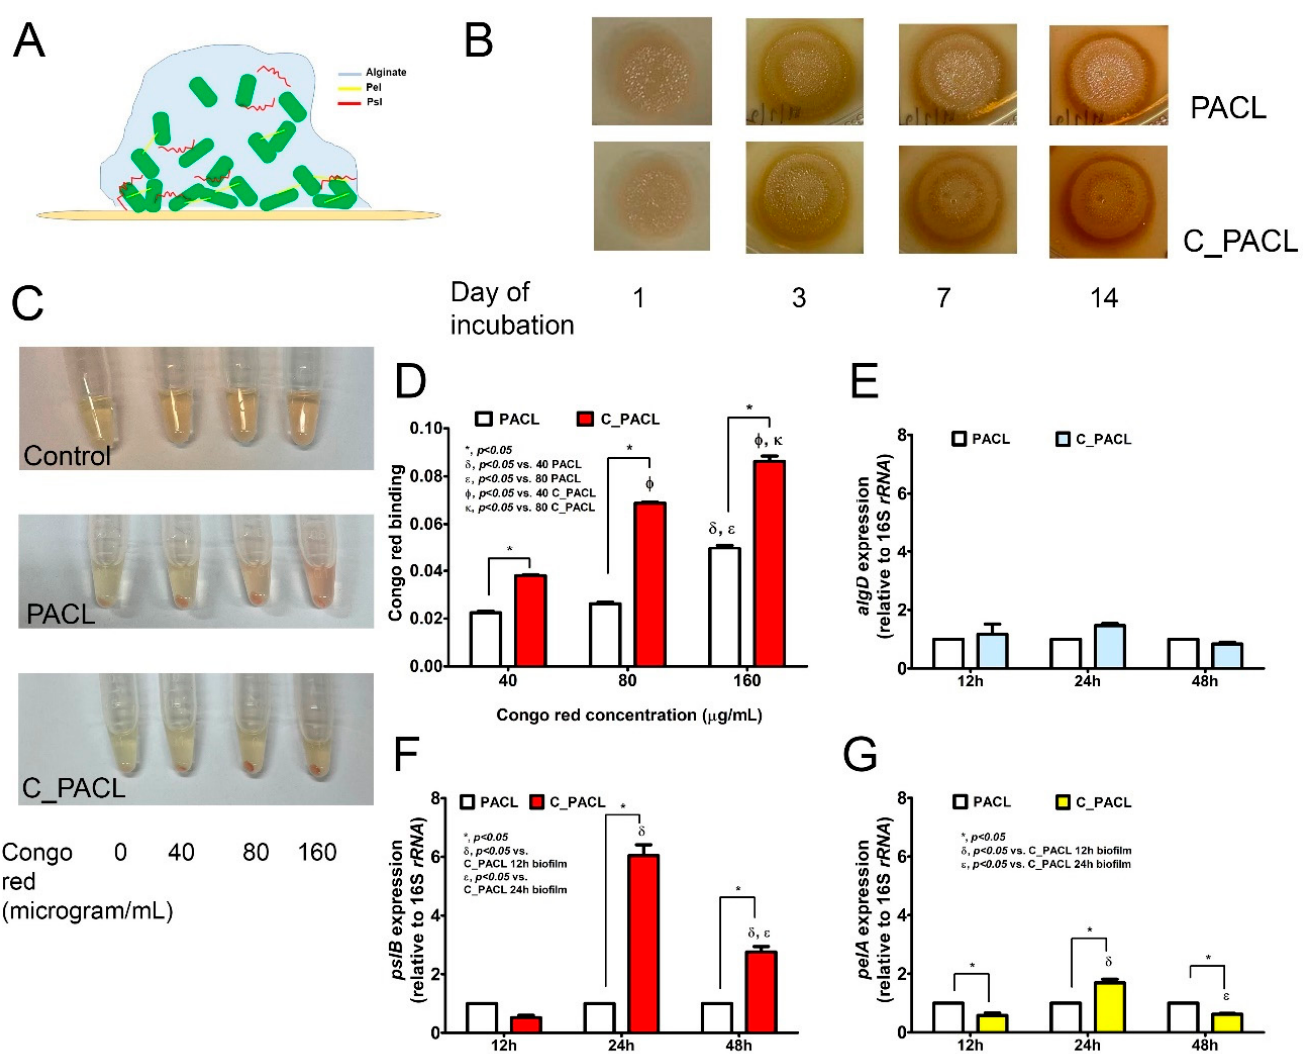
Figure 4. Exopolysaccharide (EPS) produced by P. aeruginosa parent strain (PACL) and Chlorhexidine (CHG)-treated strain (C_PACL). The graphic indicates alginate as a major component of EPS in P. aeruginosa mucoid biofilms, whereas Pel and Psl maintains biofilm strength ( A ). Colony with biofilms on Luria Broth (LB) agar supplemented with Congo red color (a color for staining of Pel and Psl in EPS) ( B ), Congo red binding activity of planktonic cells in LB broth supplemented with Congo red ( C ), the Congo red binding activity quantified by the remaining Congo red in the broth (see method) ( D ) and the expressions of algD ( E ), pslB ( F ), and pelA ( G ), the encode proteins for alginate, Pel , and Psl synthesis, as determined by qRT-PCR, are demonstrated. The experiments were performed in independent triplicate. Mean ± SEM are presented with the one-way ANOVA followed by Tukey’s analysis (*, p ˂ 0.05; Φ , p ˂ 0.05; δ , p ˂ 0.05; ε , p < 0.05; and κ , p < 0.05).